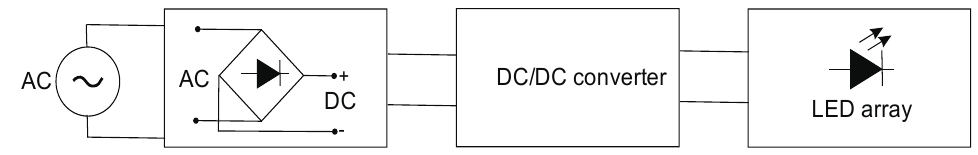
Figure 1. Block diagram of the LED lamp.